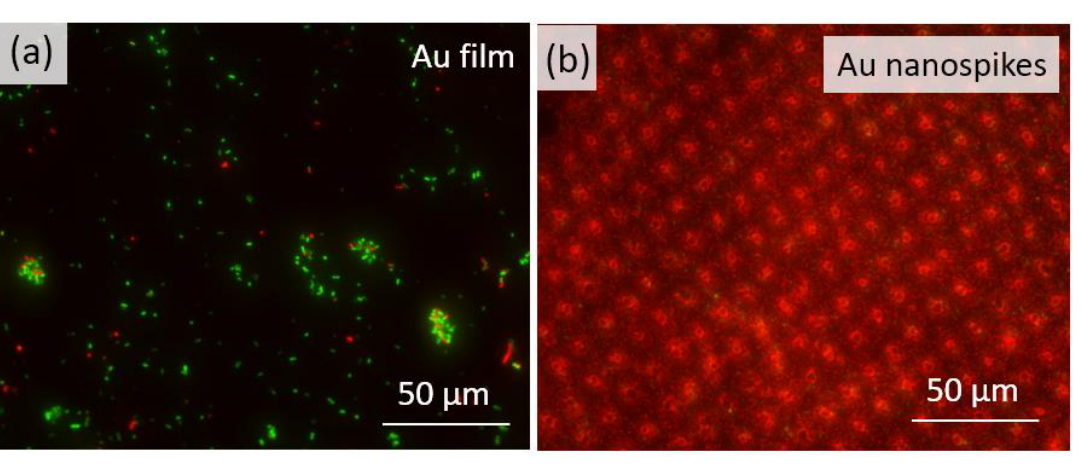
Figure 3. Fluorescent microscope photographs of alive (green) and dead (red) S. aureus bacteria on the unstructured Au film ( a ) and Au nanospikes ( b ).